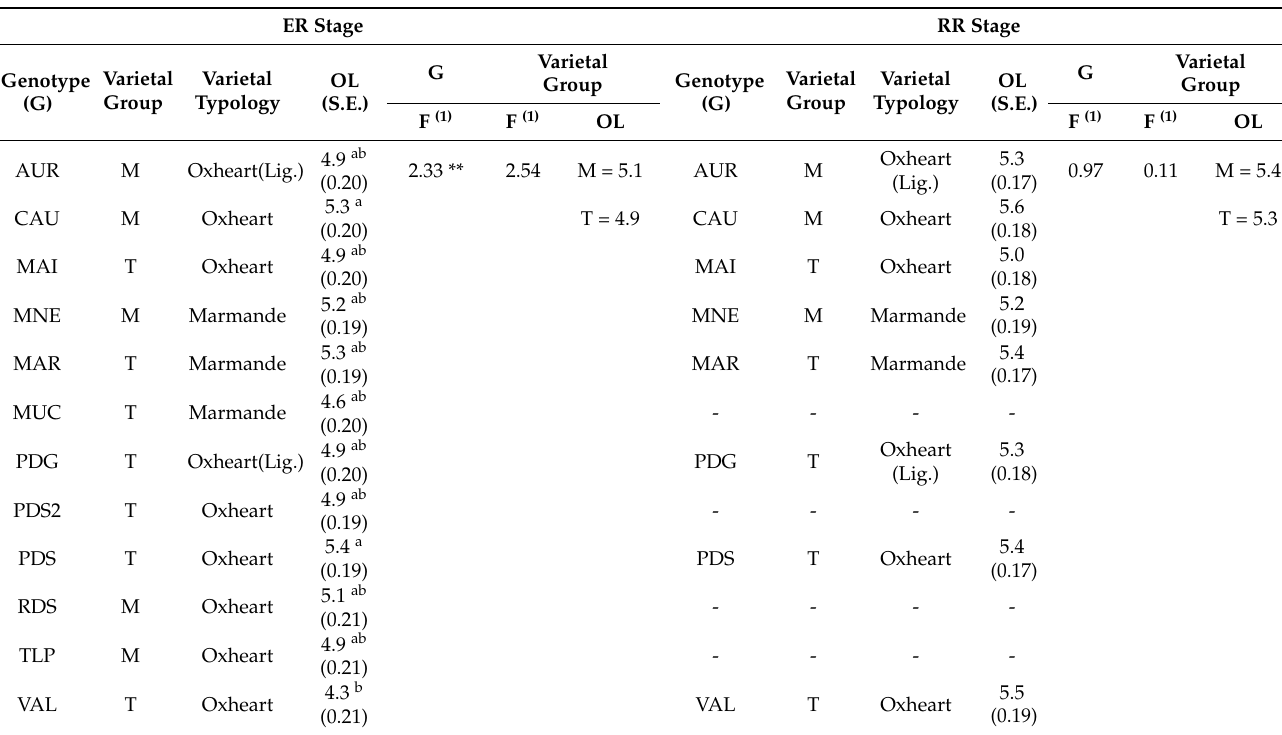
Table 5. Analysis of variance and mean overall liking (OL) ( n = 107) scores of tomato samples harvested at the early ripe (ER) and red ripe (RR) stages in Italy (9-point hedonic